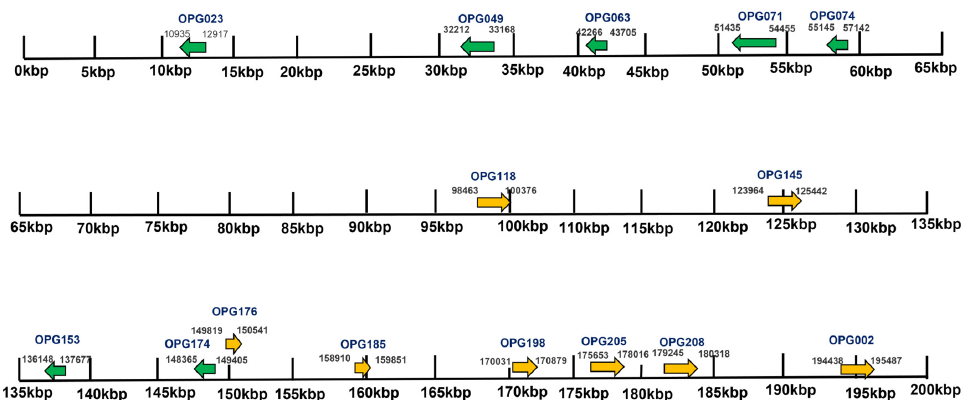
Figure 2. The mapping of the gene distribution in the Indian MPXV strain. The genes represented here in green (reverse) and yellow (forward) were highly mutated in the Indian HMPXV strain as compared to the reference sequence (MPXV-M5312_HM12_Rivers). These genes mostly occurred from 135 Kbp to 197 Kbp and from 10 Kbp to 60 Kbp in the terminal end region.